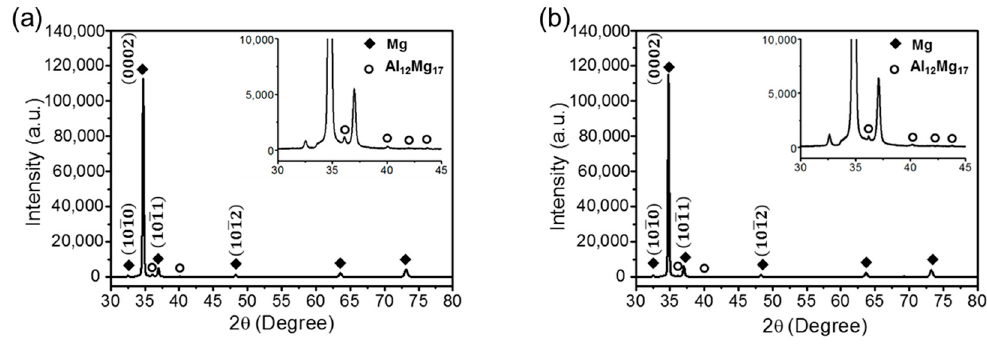
+ R and ( b ) H-ECAP + R AZ91 rolled Figure 7. XRD patterns of ( a ) C ‐ ECAP+R and ( b ) H ‐ ECAP+R AZ91 rolled alloys. Figure 7. XRD patterns of ( a ) C-ECAP